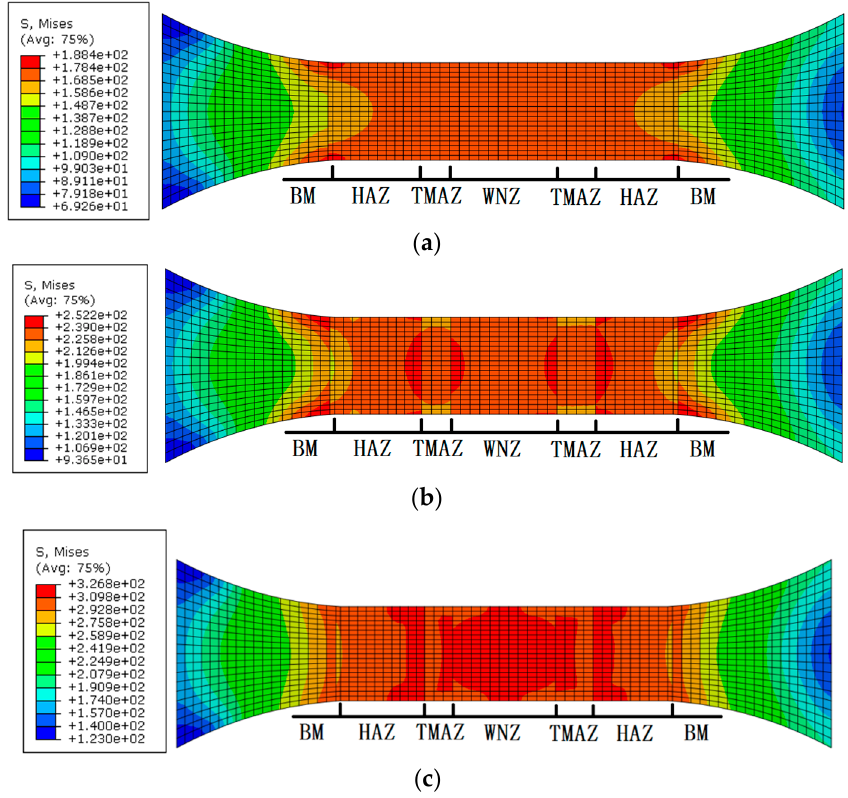
Figure 7. Von Mises stress distribution of the FSW joint under maximum stress of ( a ) 170 MPa, ( b ) 230 MPa, and ( c ) 300 MPa with the stress ratio of − 0.3 MPa.